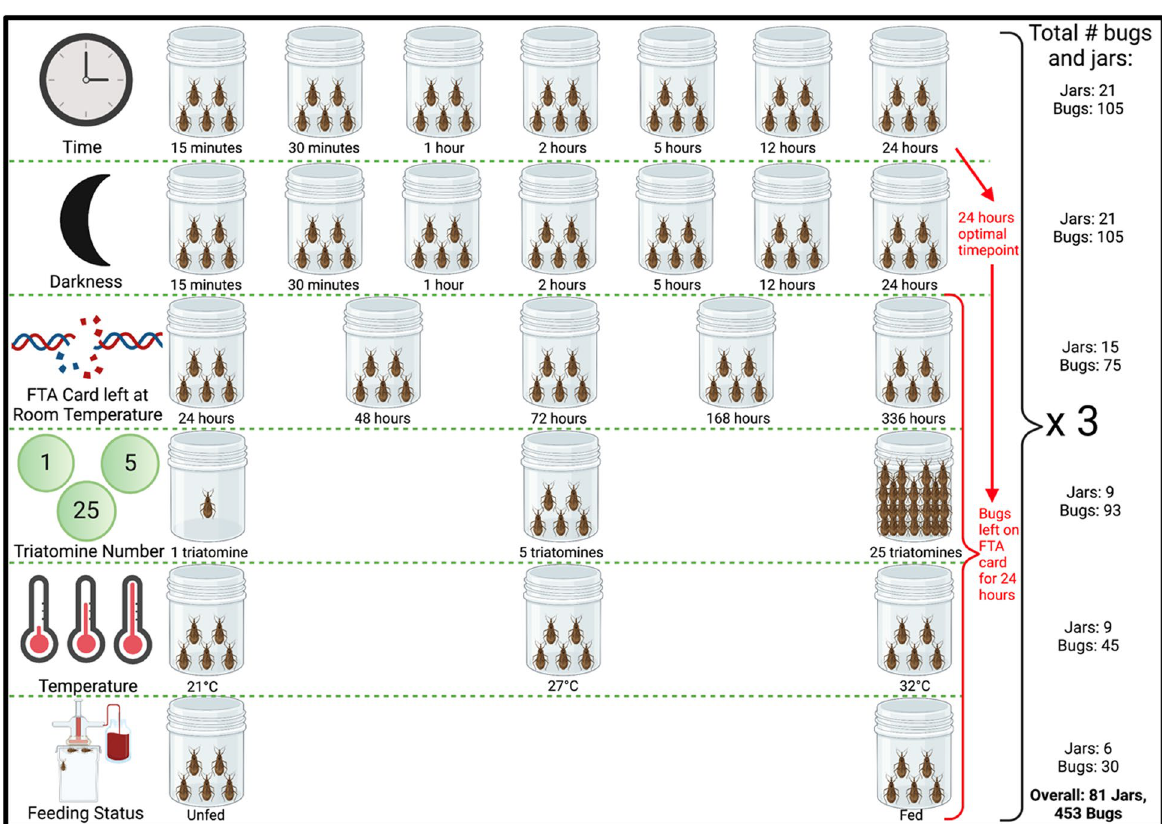
Figure 2. Design of experiments to investigate the impact of different environmental conditions on R. prolixus eDNA detection, including variables altered, number of jars and number of triatomines used. Figure created with